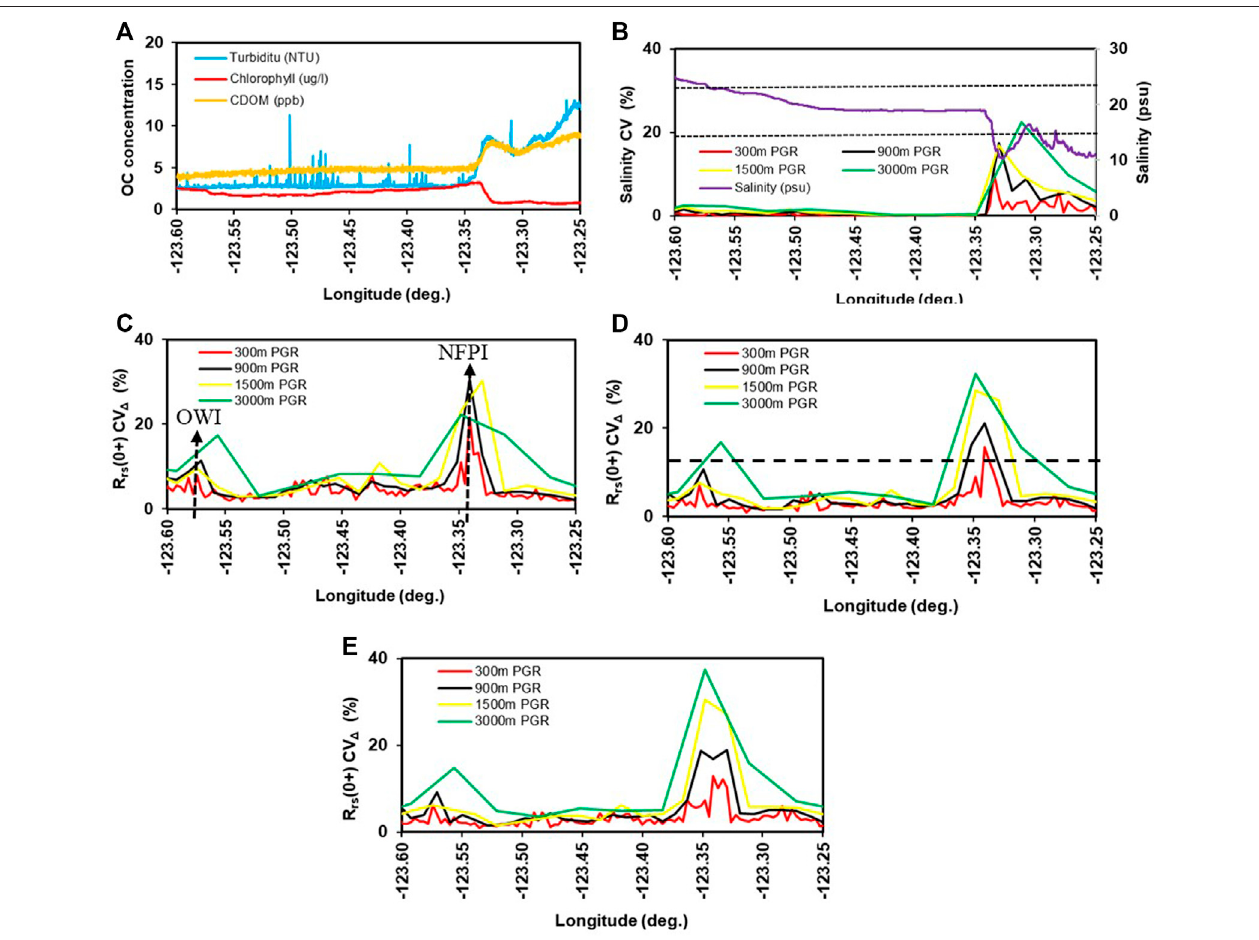
FIGURE 6 | Spatial variability analysis plot for the SoG waters along a cruise transaction on 22 August 2019. (A) Optical component (OC) concentration – turbidity, chlorophyll and CDOM; (B) corresponding salinity variability and salinity (psu). Salinity thresholds at 25 and 15 psu were indicated with dotted lines; R rs (0+) coef fi cientof variability [R rs (0+) CV Δ (%)] at different PGR 300, 900, 1500, 3000 m for, (C) Band 3 (442.5 nm), (D) Band 5 (510 nm) and Band 6 (560 nm) (E) of Sentinel 3a, OLCI sensor. R rs (0+) CV Δ R rs (0+) CV Δ threshold value, 15% is indicated in the subplot (D) as a dotted line.